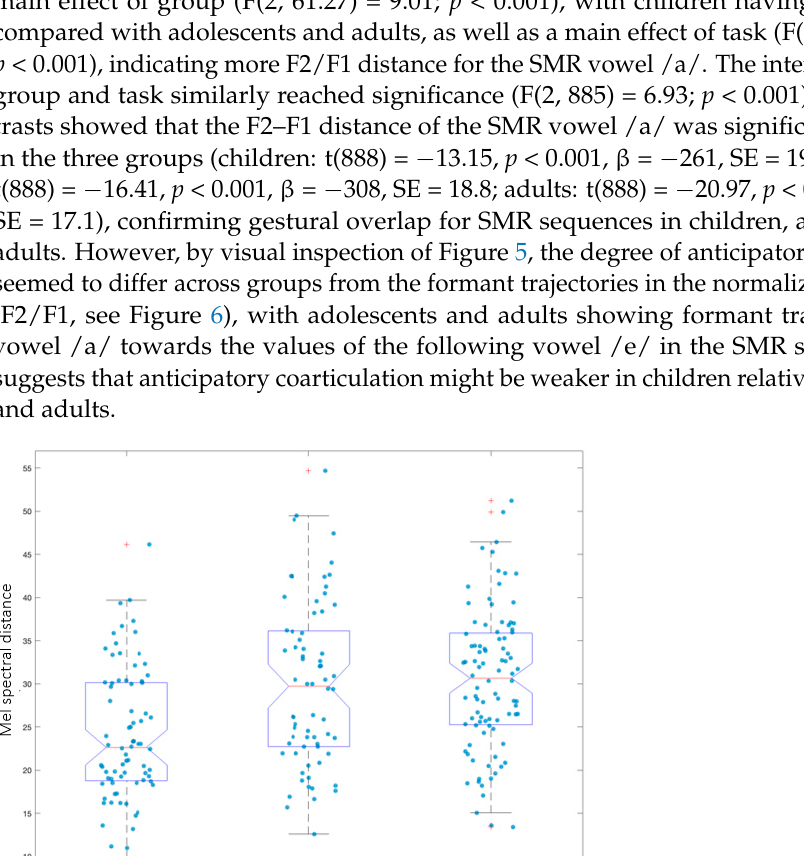
Figure 5. F2 − F1 space for the SMR and AMR /a/ vowels (colored) across age groups. Mixed models on the F2 − F1 distance of the AMR and SMR vowel /a/ (Model: lmer(F2F1~(DDK_task*group) + (1|Subject), data = data, REML = FALSE) revealed a main